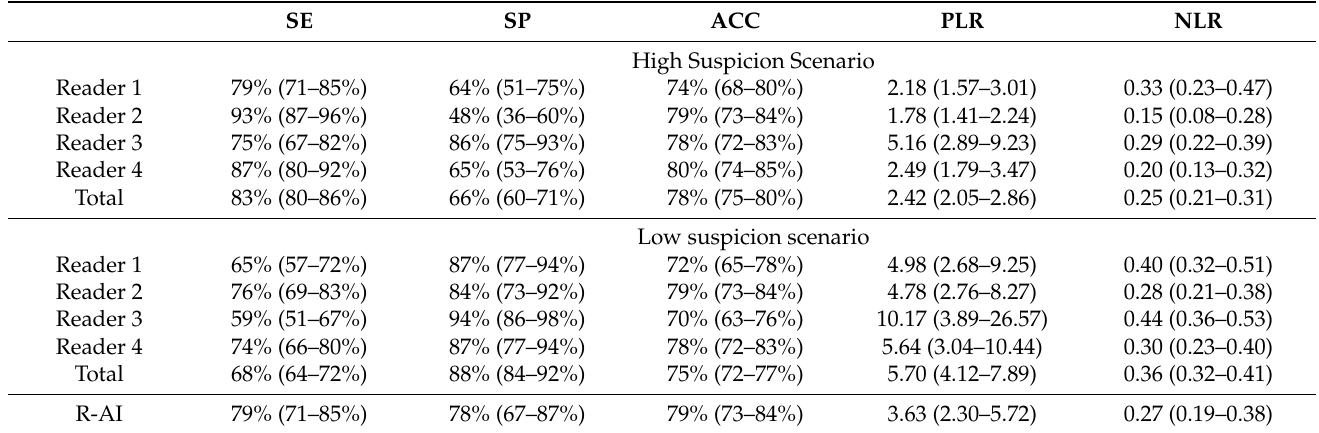
Table 4. Comparative analysis of the diagnostic performance of radiomic-based artificial intelligence classifier (R-AI) and human readers in both high and low suspicion scenarios.